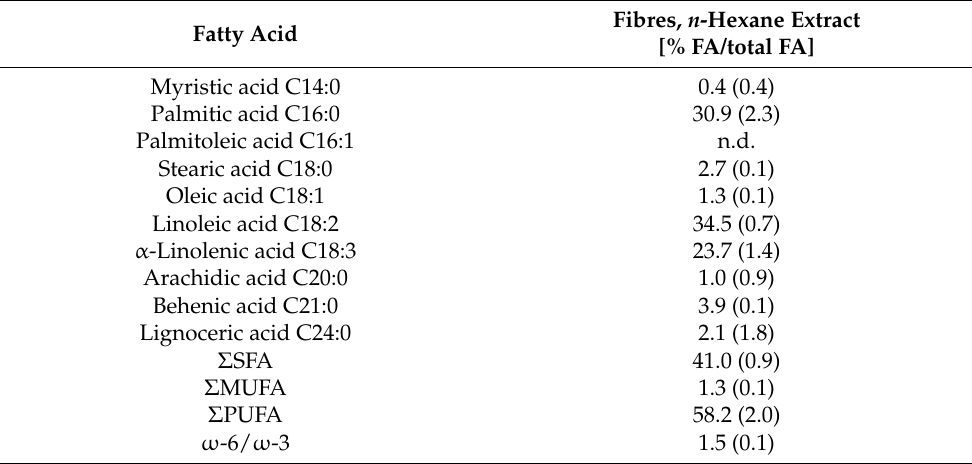
Table 2. Fatty acid profile of the lipids extracted with n -hexane from French Salicornia ramosissima fibre residue. Results are given as [% FA/total FA], n.d.: not detected. Results are expressed as mean values with standard deviations (in